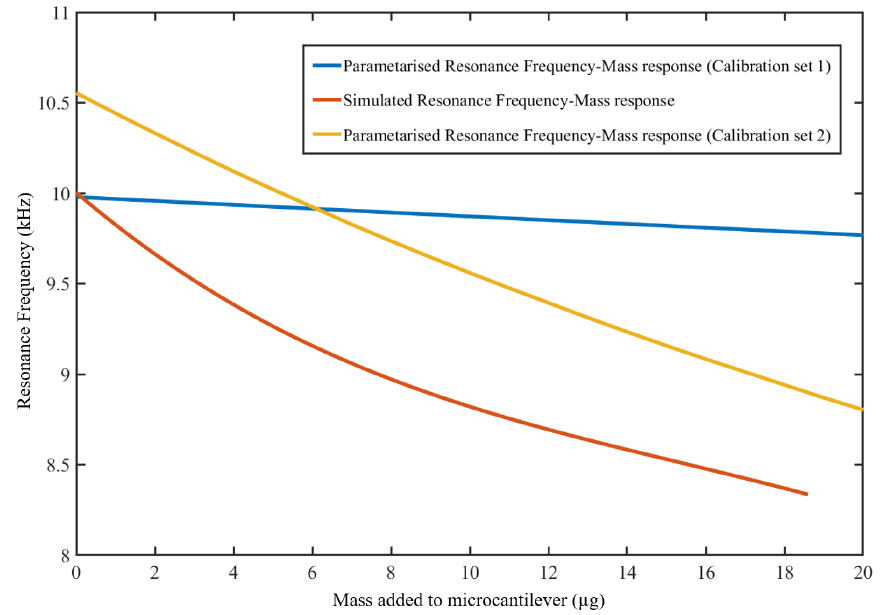
Figure 10. Comparison of simulated resonance frequency-mass response to parameterised response from calibration set-1 and calibration